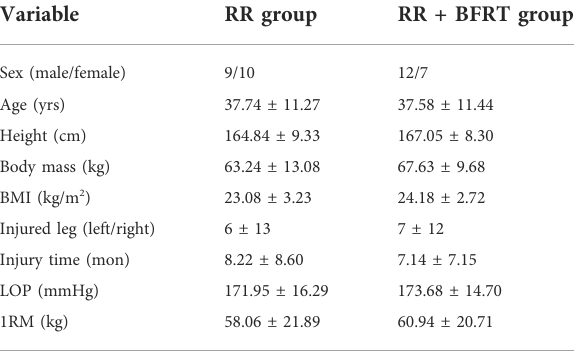
TABLE 1 Patient